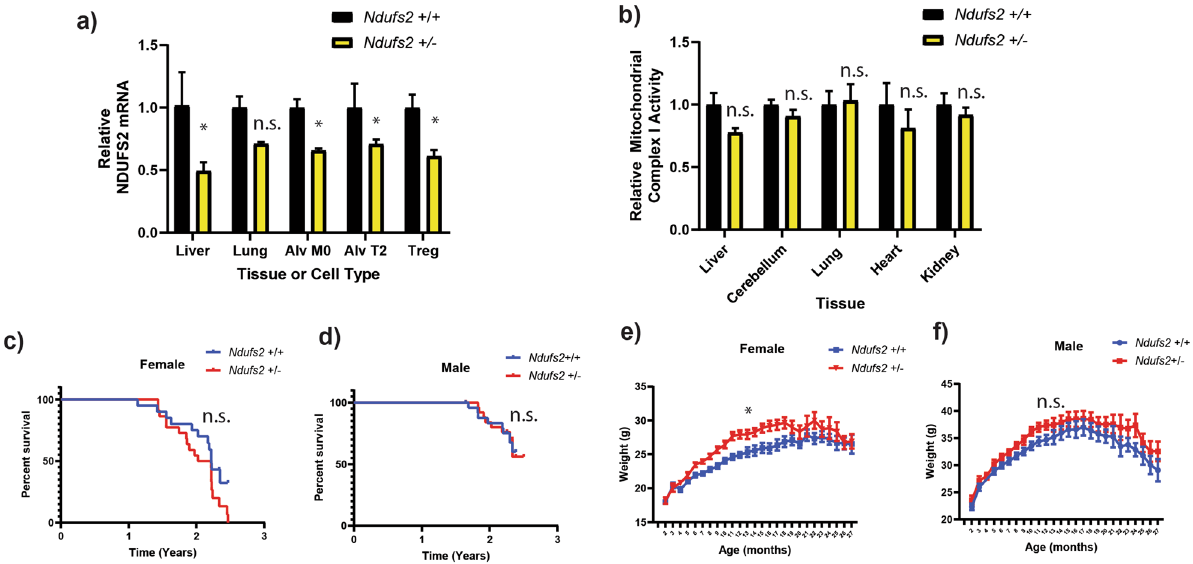
Figure 1. Ndufs2 hemizygosity decreases mRNA but does not significant impair complex I function or lifespan. ( a ) Ndufs2 mRNA quantification in cells and tissue. Two-way ANOVA column factor p < 0.0001, n = 2–4), Sidak’s multiple comparisons test * p < 0.05. ( b ) Relative complex I enzymatic activity in whole tissue. 2-way ANOVA column factor p = 0.0994 n = 5 Sidak’s multiple comparisons test not significant. ( c ) Survival of female Ndufs2 +/+ and Ndufs2 +/− mice n = 20–22. Log-rank (Mantel-Cox) test p = 0.0791. ( d ) Survival of male Ndufs2 +/+ and Ndufs2 +/- mice n = 28–29. Log-rank (Mantel-Cox) test p = 0.9842 ( e ) Average body weight by month of female Ndufs2 +/+ and Ndufs2 +/− mice. Multiple t-tests adjusted * p < 0.01: Female Ndufs2 +/− vs Female Ndufs2 +/+ months 6–12 and 16. N = 31–34. ( f ) Average body weight by month of male Ndufs2 +/+ and Ndufs2 +/− mice. n = 22. n.s. not